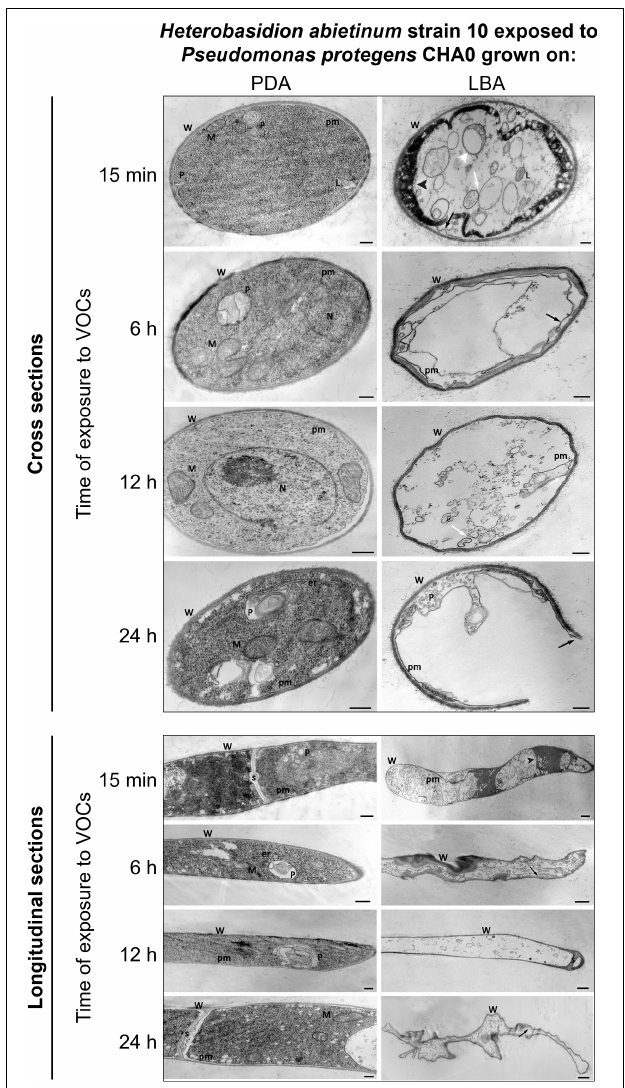
FIGURE 7 | Experiment K. Transmission electron microscope (TEM) observations. Hyphae of Heterobasidion abietinum strain 10 exposed to volatile organic compounds (VOCs) emitted by Pseudomonas protegens CHA0 grown on Luria-Bertani agar (LBA) compared to the control, i.e., fungal hyphae exposed to VOCs of the same bacterium grown on potato dextrose agar (PDA). Hyphae were sampled from an overlapping plate assay at 15 min, 6, 12, and 24 h of exposure to VOCs. Black arrow: plasma membrane detachment and rupture; white arrowhead: mitochondria vesiculation a; white arrow: pseudo-vacuoles; black arrowhead: denser cytoplasm. Asterisk: lomasome/plasmalemmasome residues; W, cell wall; M, mitochondrion; N, nucleus; L, lomasome; P, plasmalemmasome; er, endoplasmic reticulum; pm, plasma membrane; s, septum. Bars: 250 nm for the panels of longitudinal sections/PDA and cross-sections, and 500 nm for the panel of longitudinal